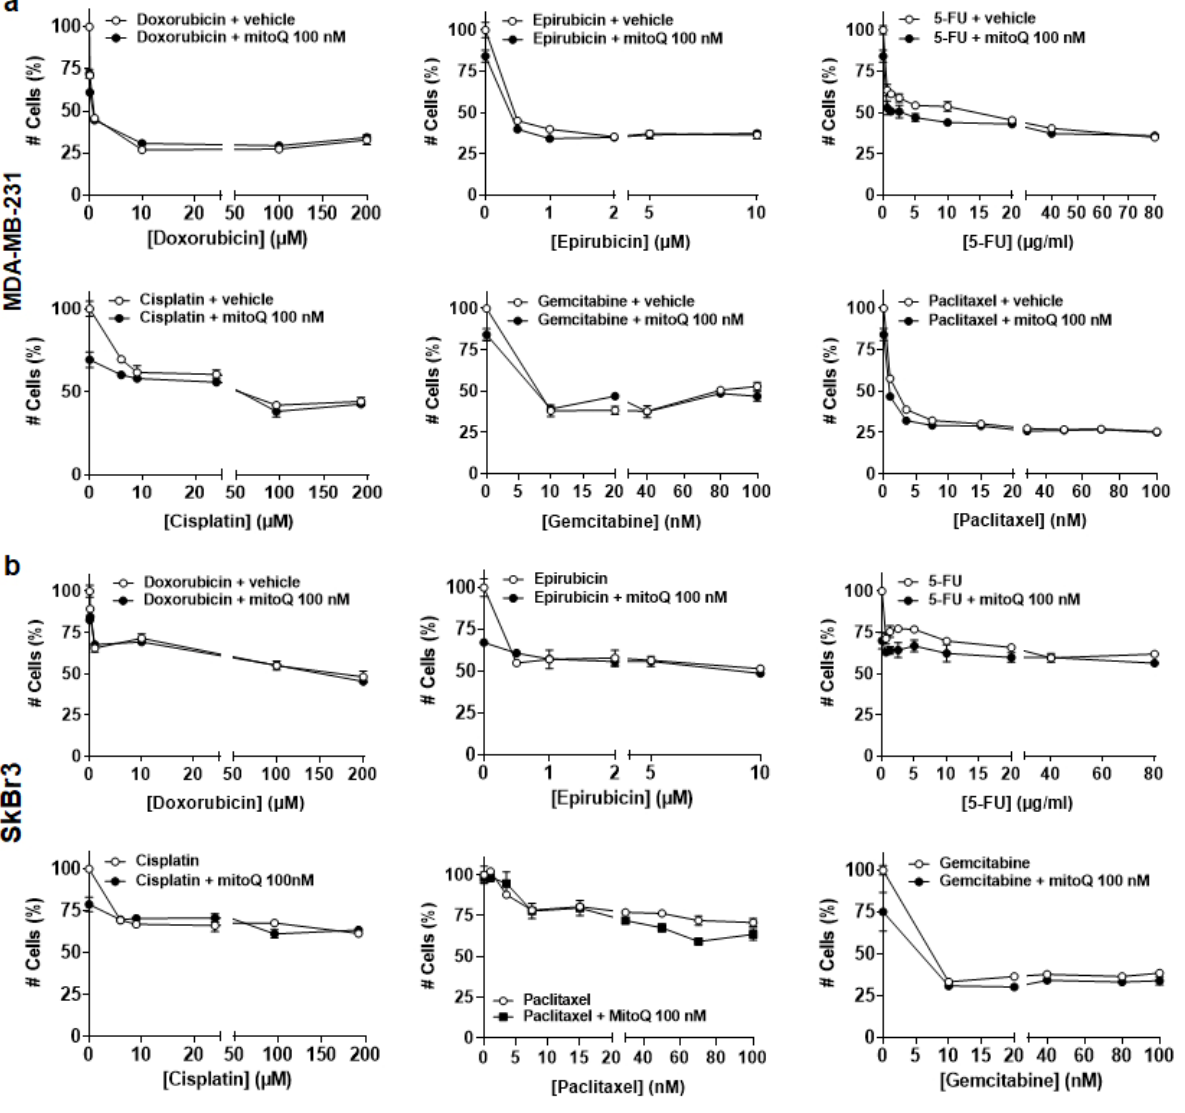
Figure 4. In vitro, MitoQ does not interfere with conventional chemotherapies used to treat breast cancer. ( a ) Counting of MDA-MB-231 cancer cells treated with increasing doses of chemotherapy ± MitoQ. Treatments were: 48 h with doxorubicin ± 100 nM MitoQ ( n = 3), 24 h with epirubicin ± 100 nM MitoQ ( n = 3), 48 h with 5-fluorouracil (5-FU) ± 100 nM MitoQ ( n = 3), 48 h with cisplatin ± 100 nM MitoQ ( n = 3), 72 h with gemcitabine ± 100 nM MitoQ ( n = 3), and 48 h with paclitaxel ± 100 nM MitoQ ( n = 3). ( b ) As in a, but using SkBr3 cancer cells ( n = 3–4). All data are shown as means ± SEM. All p values are > 0.05; by 2-way ANOVA with Tukey’s post-hoc test ( a , b ).